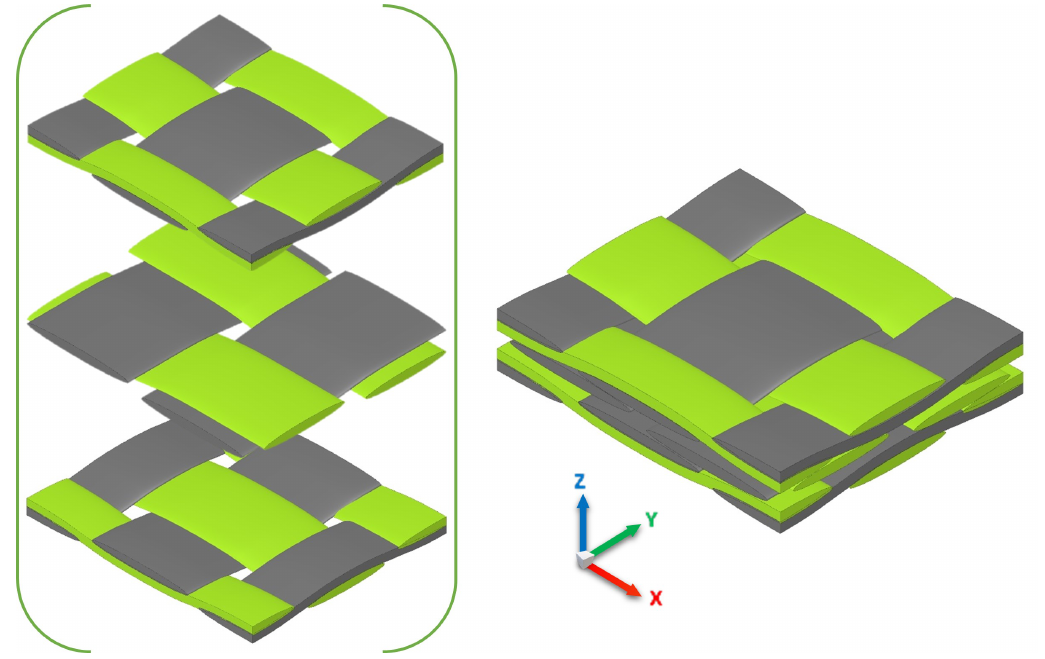
Figure 10. Stacking and nesting of layers in a laminate: three multi-layer woven